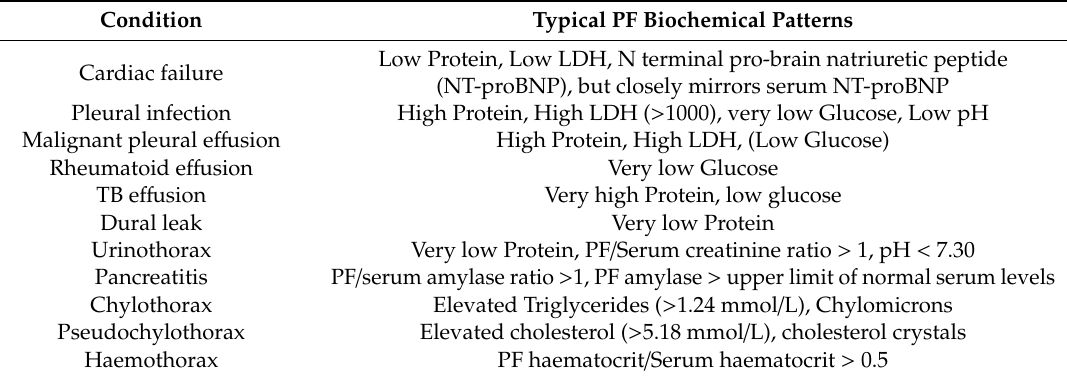
Table 3. Typical PF biochemical patterns [8,13,34,35].